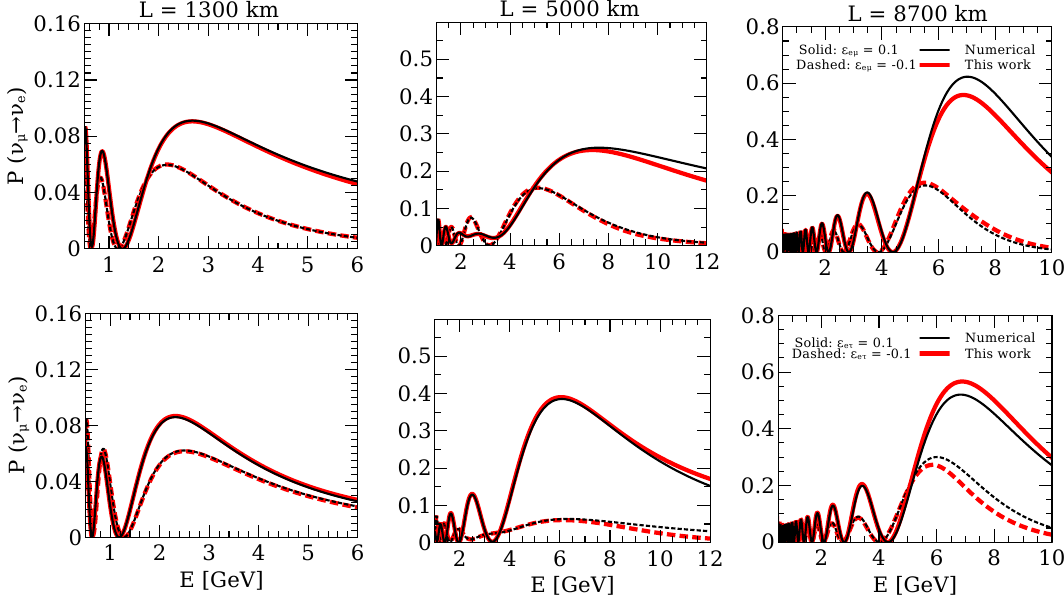
Figure 14 . Comparison of ν µ → ν e appearance probability estimated from our approximate analytical expressions (red curves), and the numerical calculations obtained from GLoBES (black curves) in the presence of NC-NSI parameters ε (upper panels) and ε (lower panels) one-at-a- eµ eτ time. The three different columns correspond to the three different baselines: 1300 km (left panels), 5000 km (middle panels), and 8700 km (right panels). The solid (dashed) curves are obtained using a value of 0.1 ( − 0 . 1 ) for the NSI parameters. Values of the three-flavor oscillation parameters are taken from table 2. We assume θ = 45 ◦ and 23